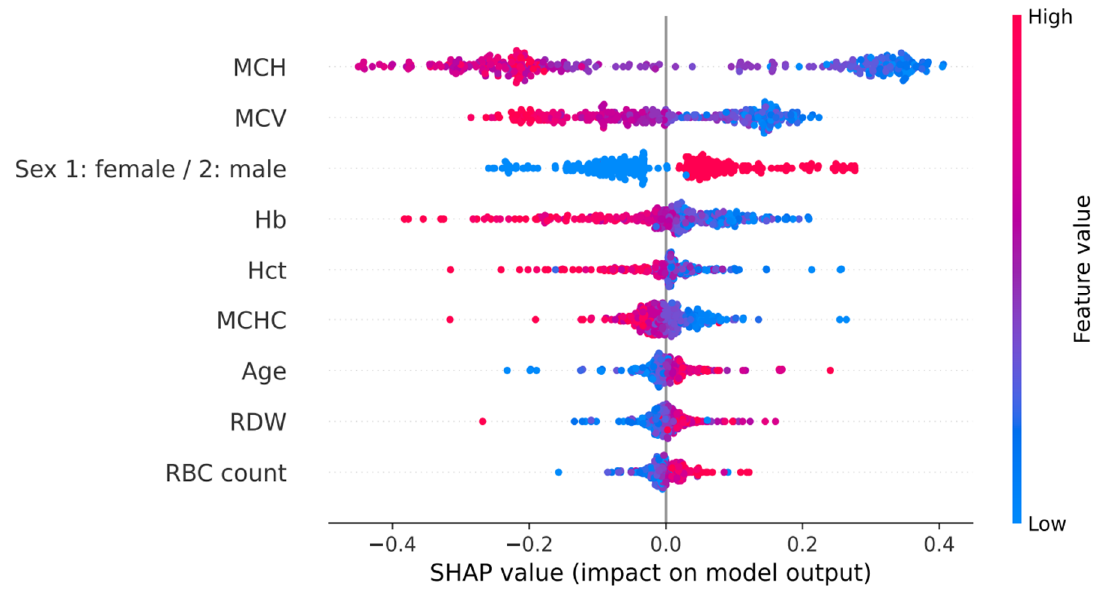
Figure 2. Performance comparison of the top three ML-based models on the training ( A , B ) and independent test ( C , D ) datasets. Prediction results of the top three ML-based models in terms of ACC, Sn, Sp, and MCC ( A,C ). ROC curves and AUC values of the top three ML-based models ( B , D ). SVM, support vector machine; MLP, multilayer perceptron; ACC, accuracy; AUC, area un- der the curve; MCC, Matthews correlation coefficient; ML, machine learning; Sn, sensitivity; Sp, specificity.